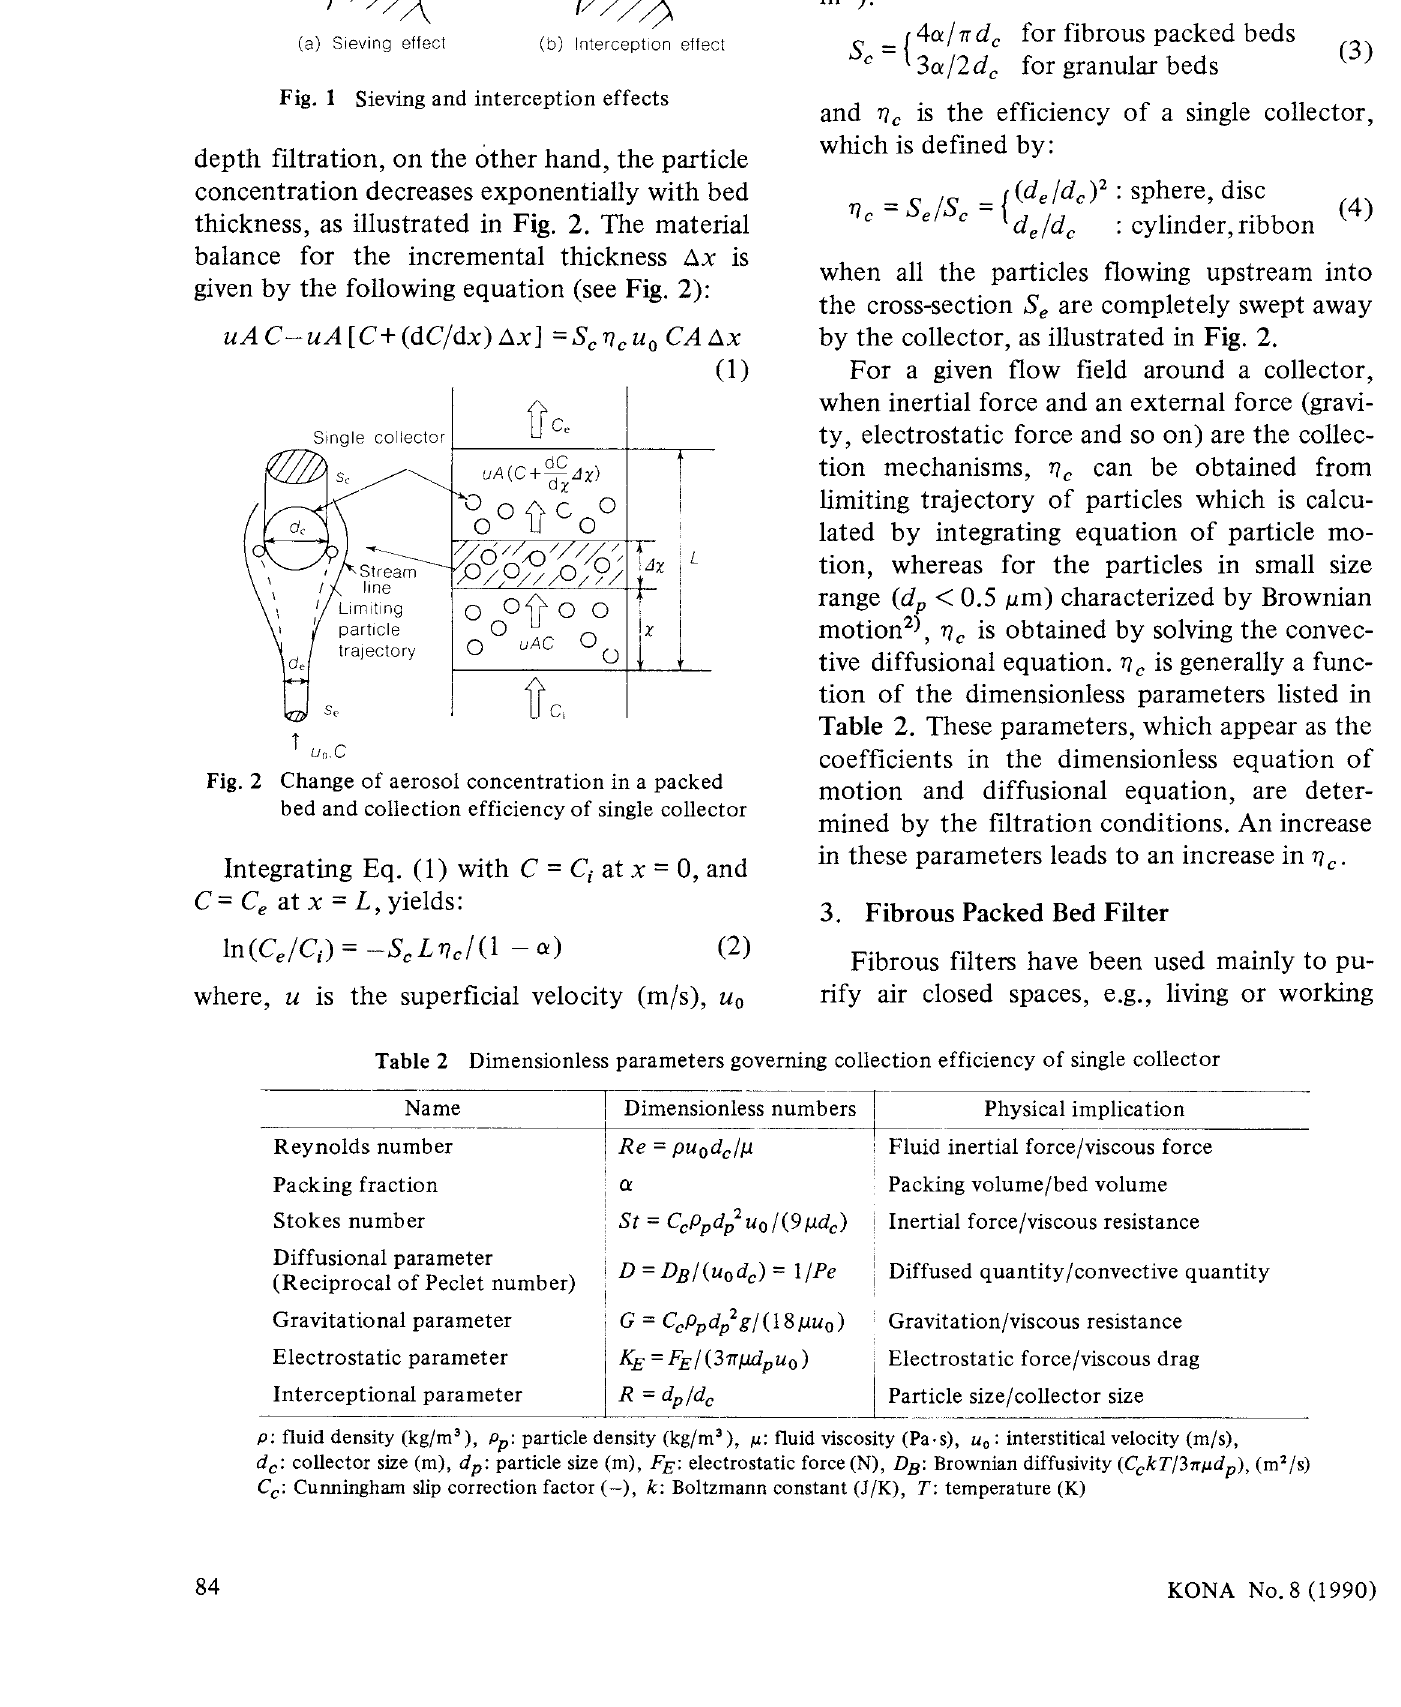
Fig. 1 Sieving and interception effects